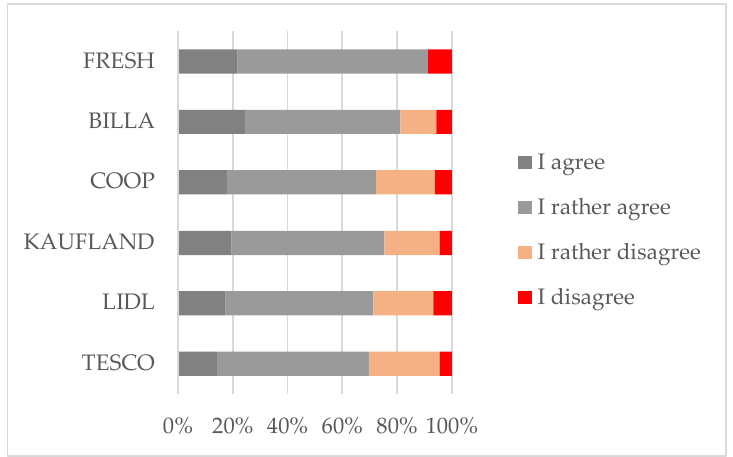
Figure 6. Respondents’ opinion on the seller’s characteristic “pleasant aroma”.